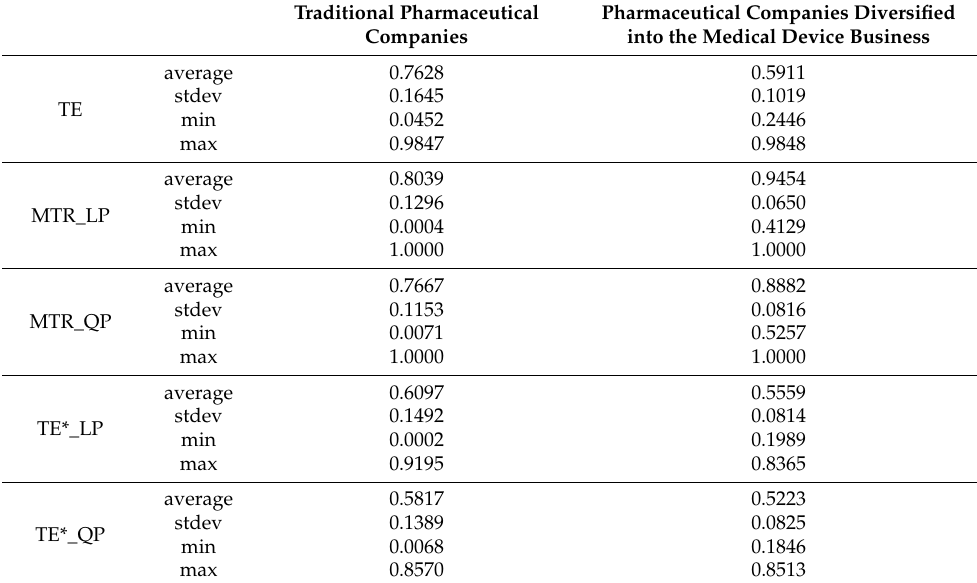
Table 3. SFA estimates of technical efficiencies and meta-technology